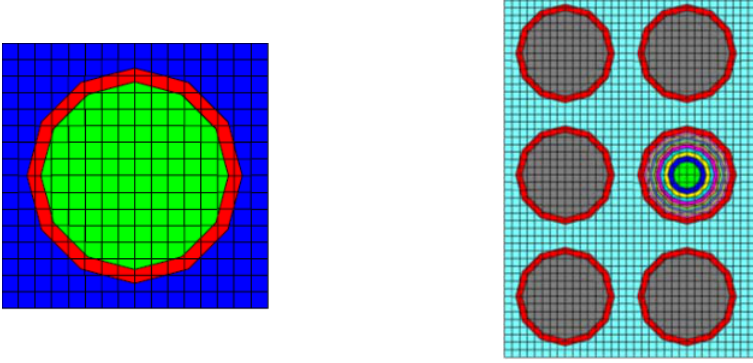
Figure 3. Mesh grid used in SCALE-6.2 for BWR pin-cell ( left ) and BWR 3 by 3 array with gadolinia rod ( right ) models.